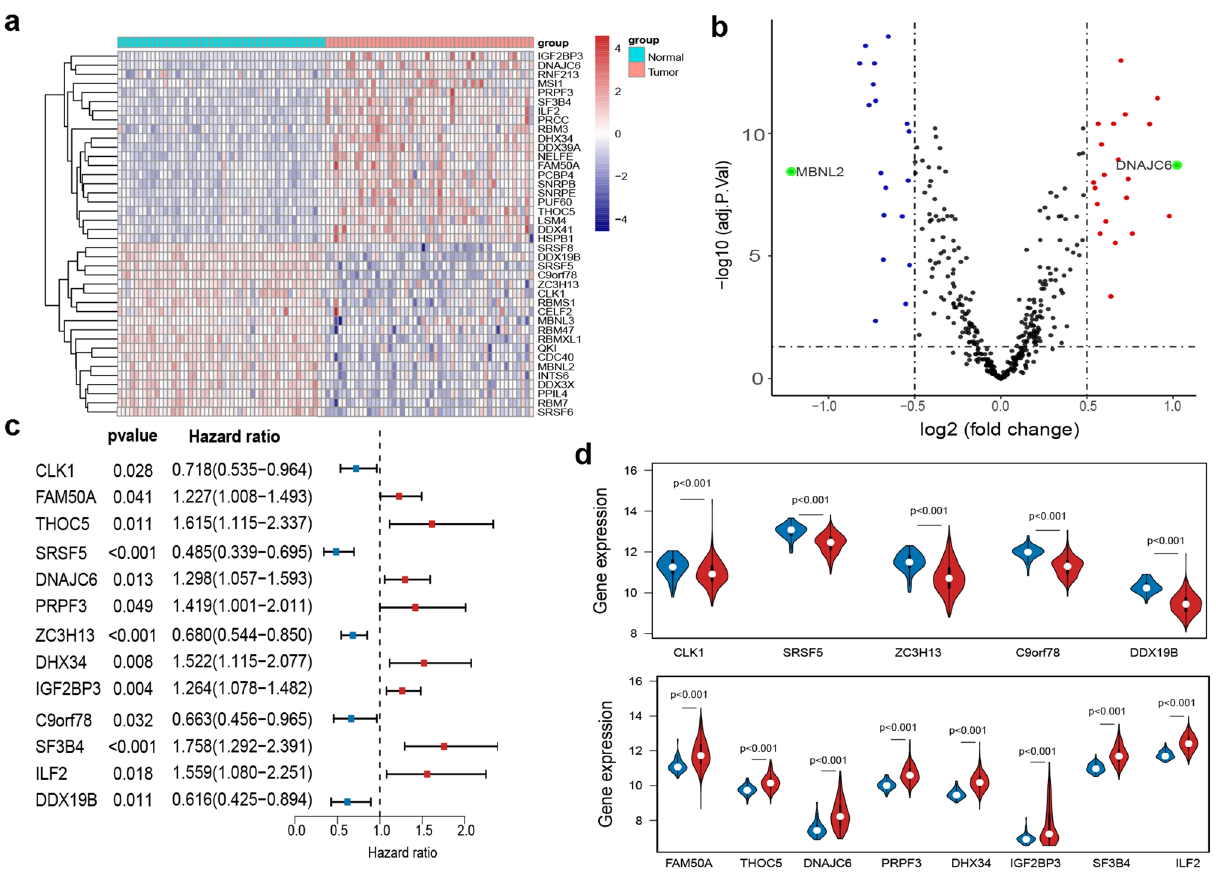
Figure 2. Identification of dysregulated SFs and survival-associated SFs in HCC. ( a ) Heatmap of differentially expressed SFs between 50 pairs of normal tissues and tumor tissues of HCC (|log2FC|≥ 0.5, adjusted P < 0.05). ( b ) Volcano plot of differentially expressed SFs in HCC. The red and blue dots represent upregulated and downregulated SFs respectively; the green dots represent the dysregulated SFs with |log2FC|≥ 1; the black dots represent the SFs with no significant difference. ( c ) Forest plot of hazard ratios for survival-associated SFs in HCC. The red and blue boxes represent risk factors or protective factors of HCC, respectively. ( d ) Violin plots showing the expression of survival-associated SFs in 50 normal tissues (blue) and 371 HCC tissues (red). SFs presented in upper were protective factors for HCC patients; SFs presented in lower were risk factors for HCC